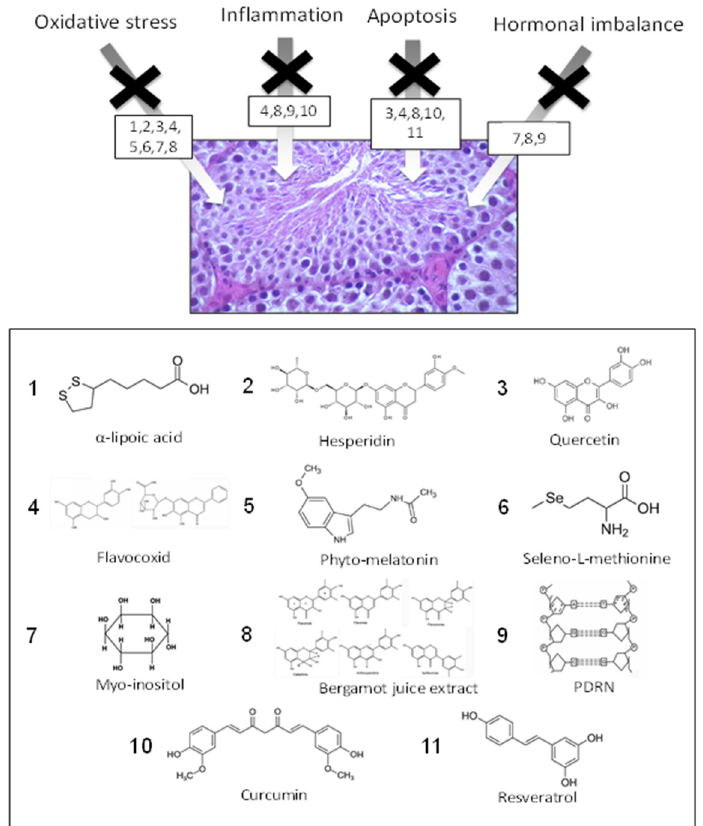
Figure 1. Structure of the nutraceuticals that are proposed to be effective against Cd-induced testicular injury. It is interesting to observe that in the majority of chemical structures here reported, multiple hydroxyl groups that typically confer a greater antioxidant (radical scavenging) capacity are present. This biochemical feature could functionally help to reduce inflammation and apoptosis, and modulate hormonal imbalance in Cd-induced testicular injury.